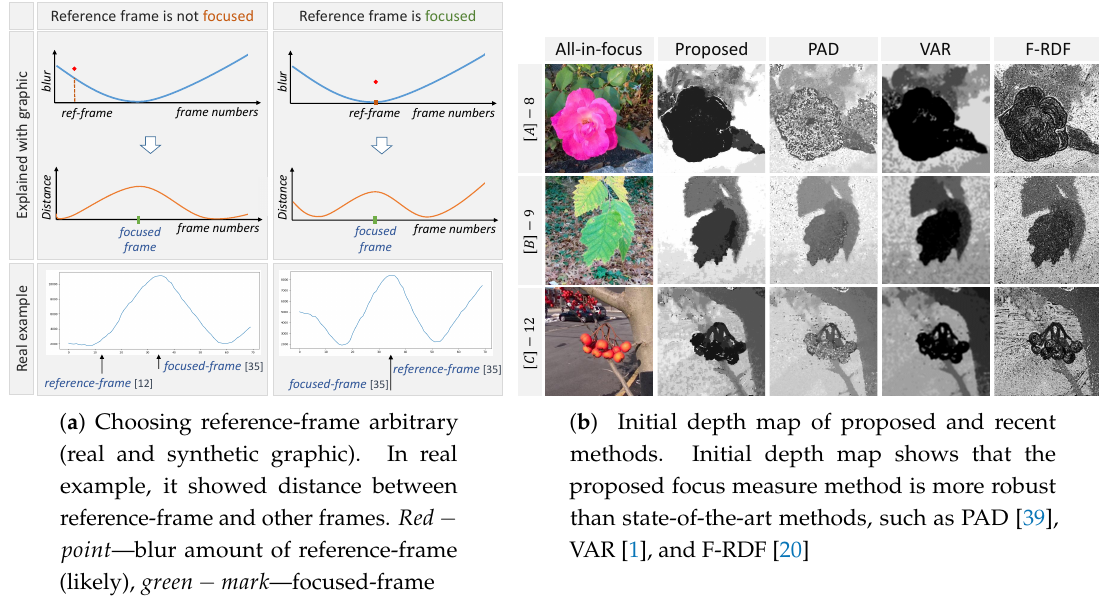
Figure 5. ( a ) Choosing reference frame arbitrary; ( b ) initial depth result of DFF